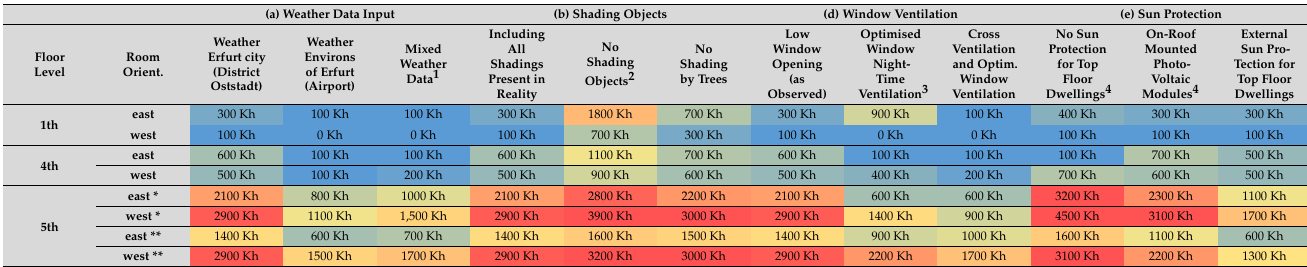
Table 4. Overtemperature degree hours for the one at a time (OAT) sensitivity analysis varying single boundary conditions (corresponding room temperature time series see in Figure 7).